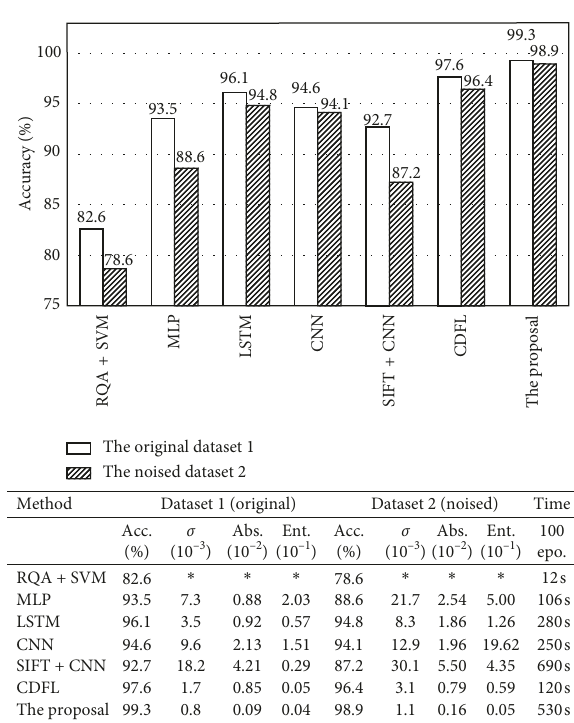
Figure 14: The performances of all methods. ∗ Values are non- existent because of the use of multiple classifiers in RQA